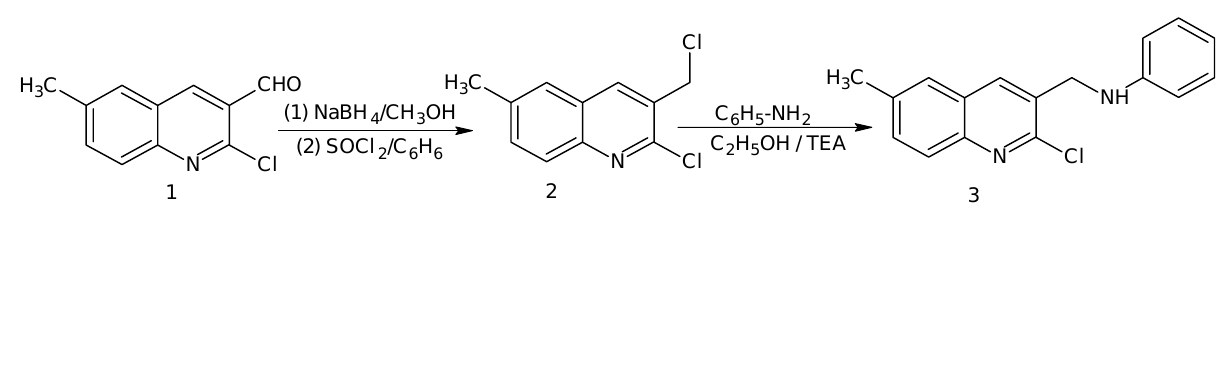
Figure 1. Synthetic route to the title compound 3